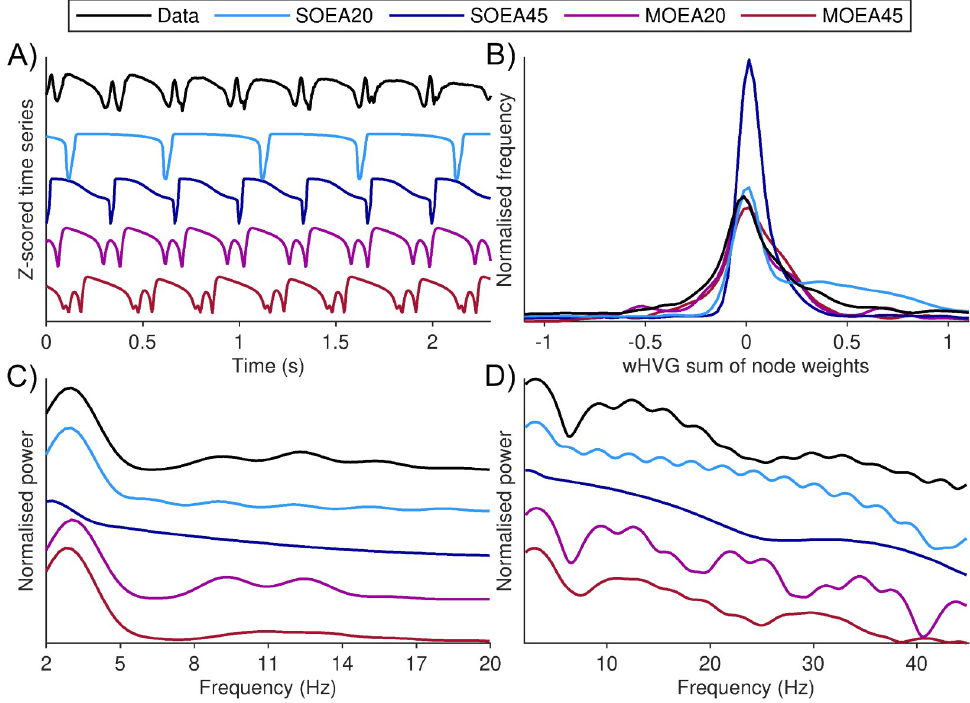
Fig 12. MOEA algorithms can uncover the presence of a SWD rhythm in the model. A) shows a segment of EEG displaying spike-wave dynamics, along with simulations of the model at the optimal parameters recovered using each algorithm (colours as per legend). Optimal refers to the smallest Euclidean distance from the origin in objective space. B) shows the corresponding wHVG distribution for the data and model simulations using the optimal parameters recovered from each algorithm. These signals show a density approximation of the distribution, calculated from 100 equally sized bins (see Methods). C) and D) show the corresponding PSD in the 2–20Hz and log-transformed 2–45Hz range, respectively. To better differentiate between the signals, the baseline of the normalised power is shown with an offset for each algorithm. The SWD data was recorded from frontal scalp EEG electrodes from a patient with absence epilepsy at Inselspital Bern,